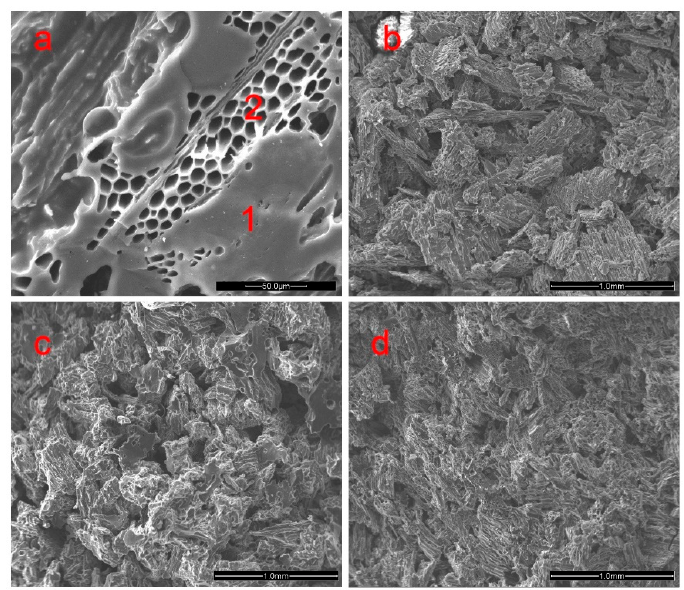
Figure 2. The microstructures of woodceramics under different carbonization temperatures (wood: resin = 40:60). ( a ) amorphous carbon and glassy carbons; ( b ) 650 °C; ( c ) 800 °C; and ( d ) 1000 °C.